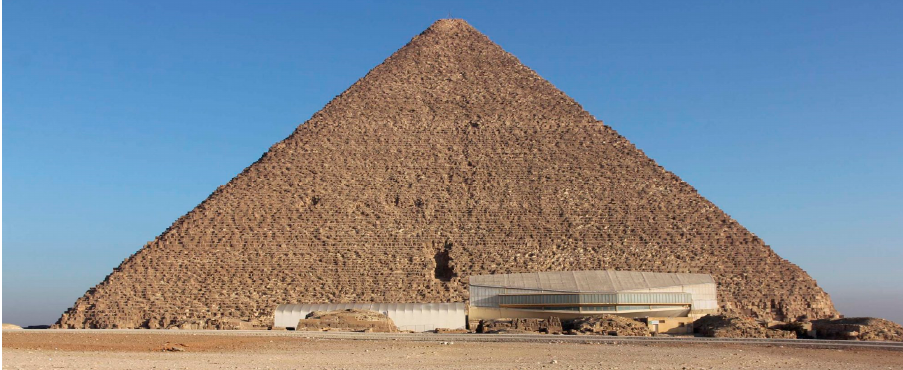
Figure 1. Location of Khufu’s second boat site in the south side of the Great Pyramid, Giza, Egypt.